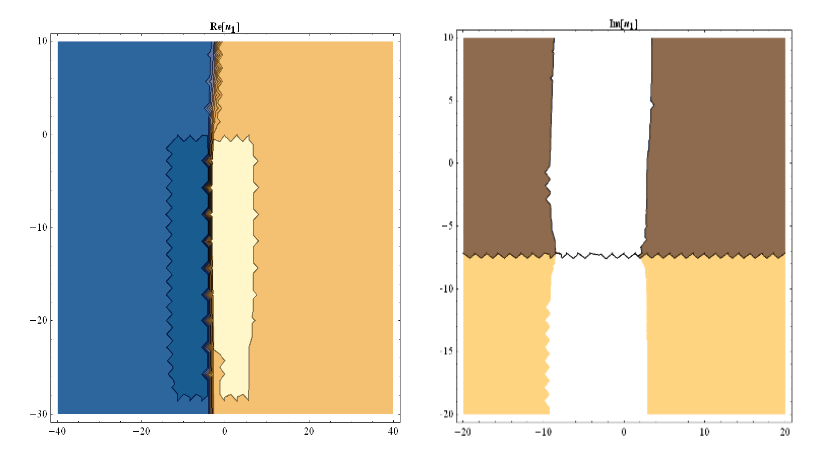
Figure 11. Contour graphs of imaginary and real part of (29).